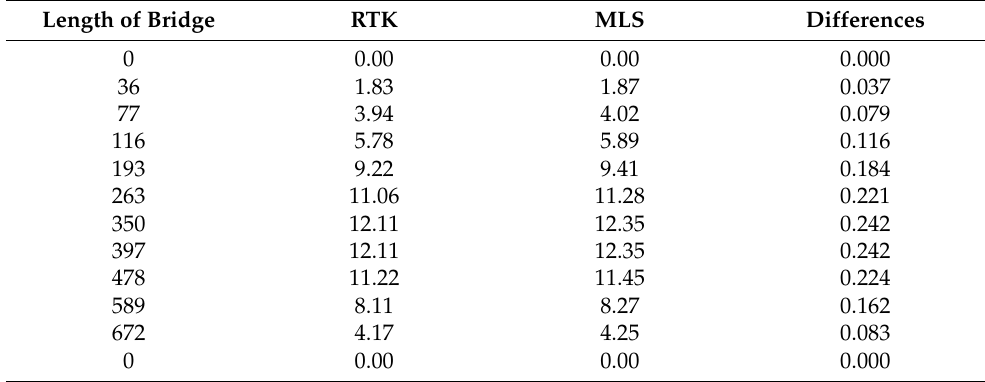
Table 1. The bridge profile data (m).